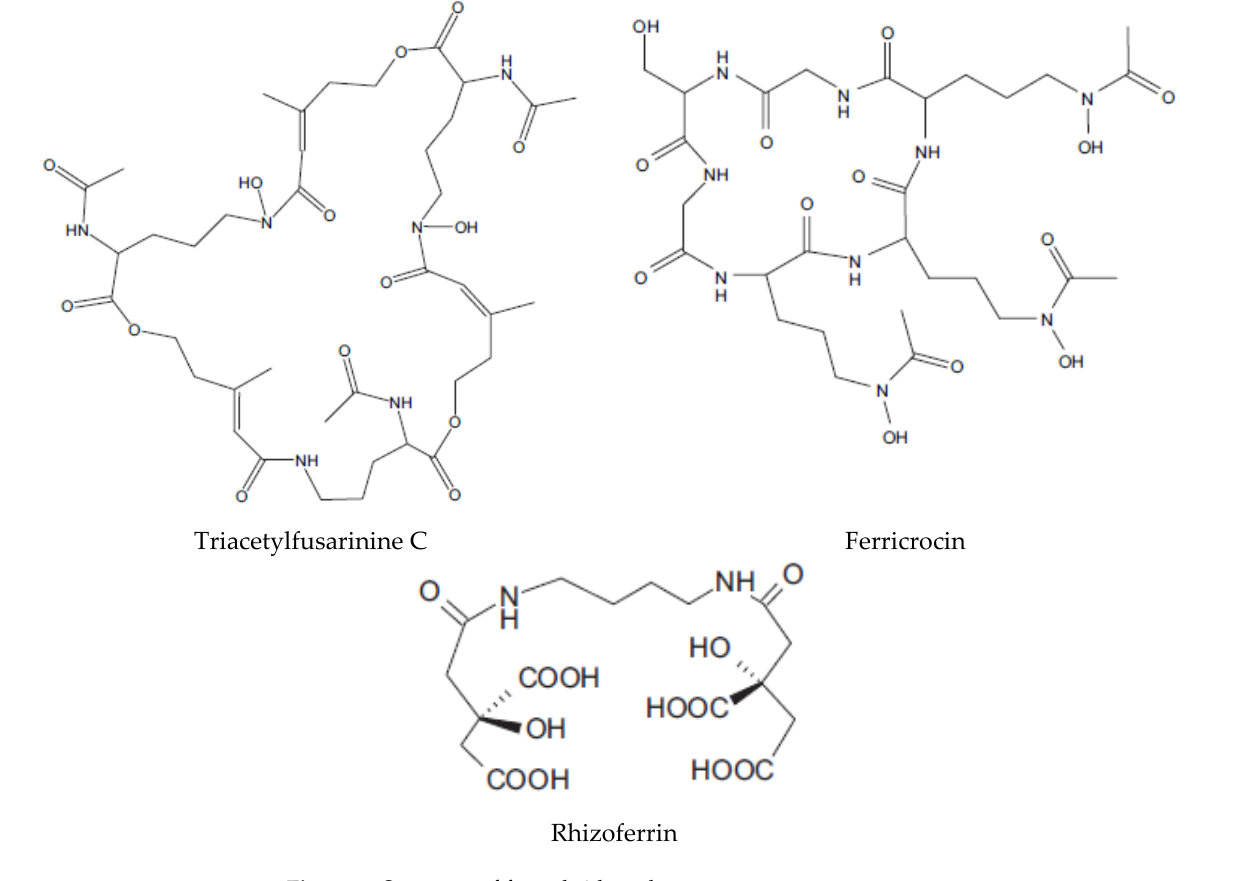
Figure 2. Structure of fungal siderophores. Table 2. Some examples of fungal siderophores.